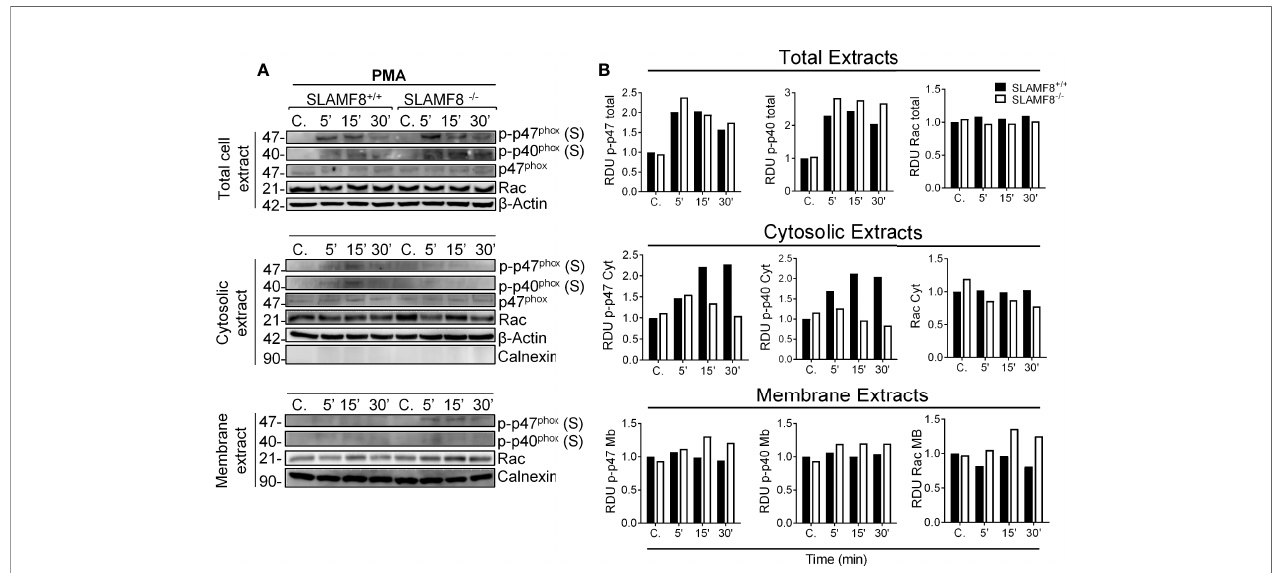
FIGURE 2 | SLAMF8 -/- pMø show increased mobilization of cytosolic NOX2 subunits to the membrane. Analysis of Rac GTPase, p-p47 phox , and p-p40 phox mobilization in SLAMF8 +/+ and SLAMF8 -/- pMø stimulated with PMA (100 ng/ml). (A) Representative Western blots of total cell, cytosolic, and membrane extracts from SLAMF8 +/+ and SLAMF8 -/- pMø treated with PMA at different time points. Absence and presence of Calnexin indicated purity of cytosolic and membrane extracts, respectively. (B) Relative expression levels of proteins indicated in A, representative data of one out of two independent experiments. C, control; S, serine; T, threonine; RDU, relative densitometry